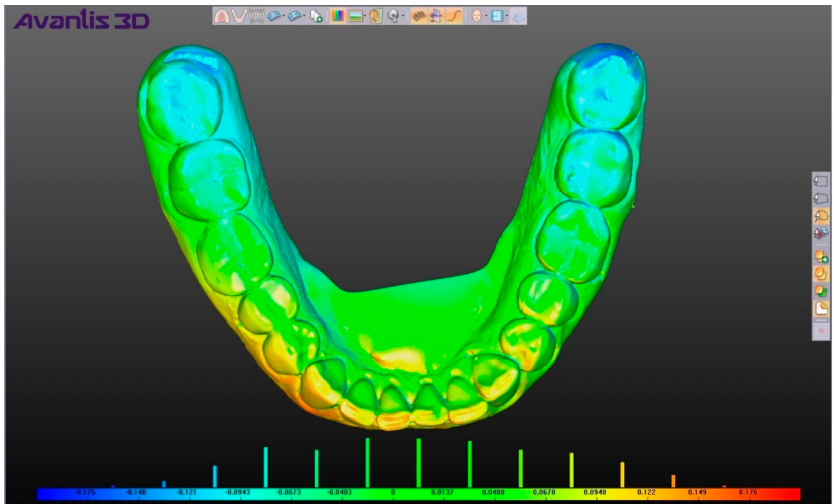
Figure 5. Chart in tool “shell–shell comparison” of program Avantis 3D (range of scale from 0.175 to − 0.175 mm).